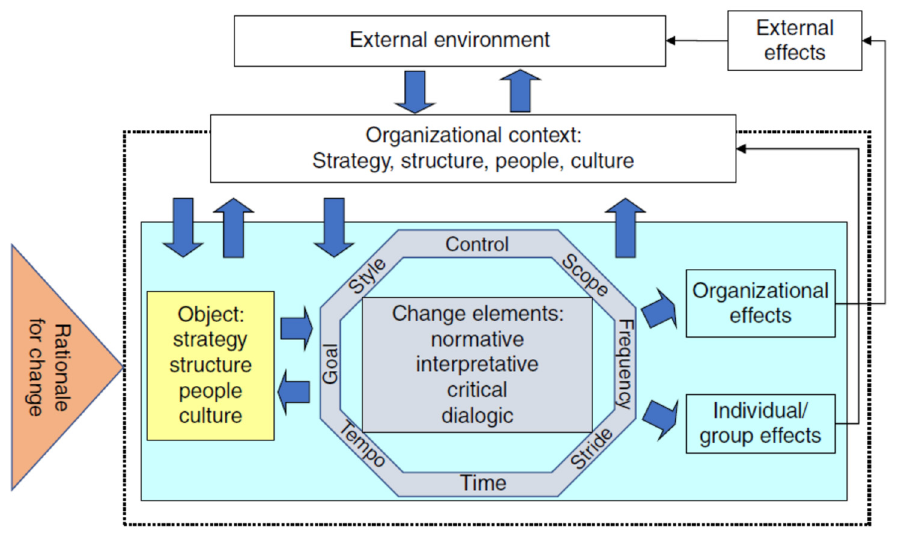
Figure 1. The generic systems model of organizational change (Maes and Van Hootegem 2019).